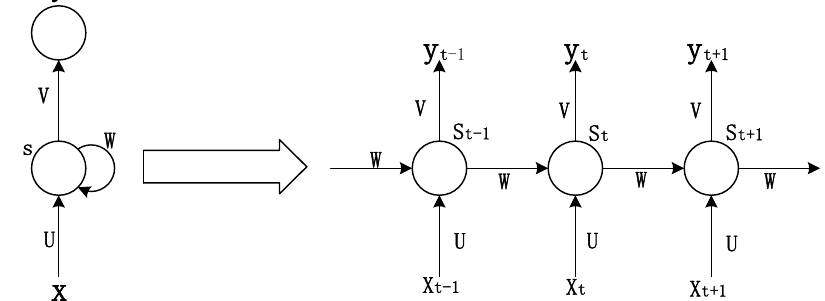
Figure 2. Recurrent neural network model with multiple hidden layers.